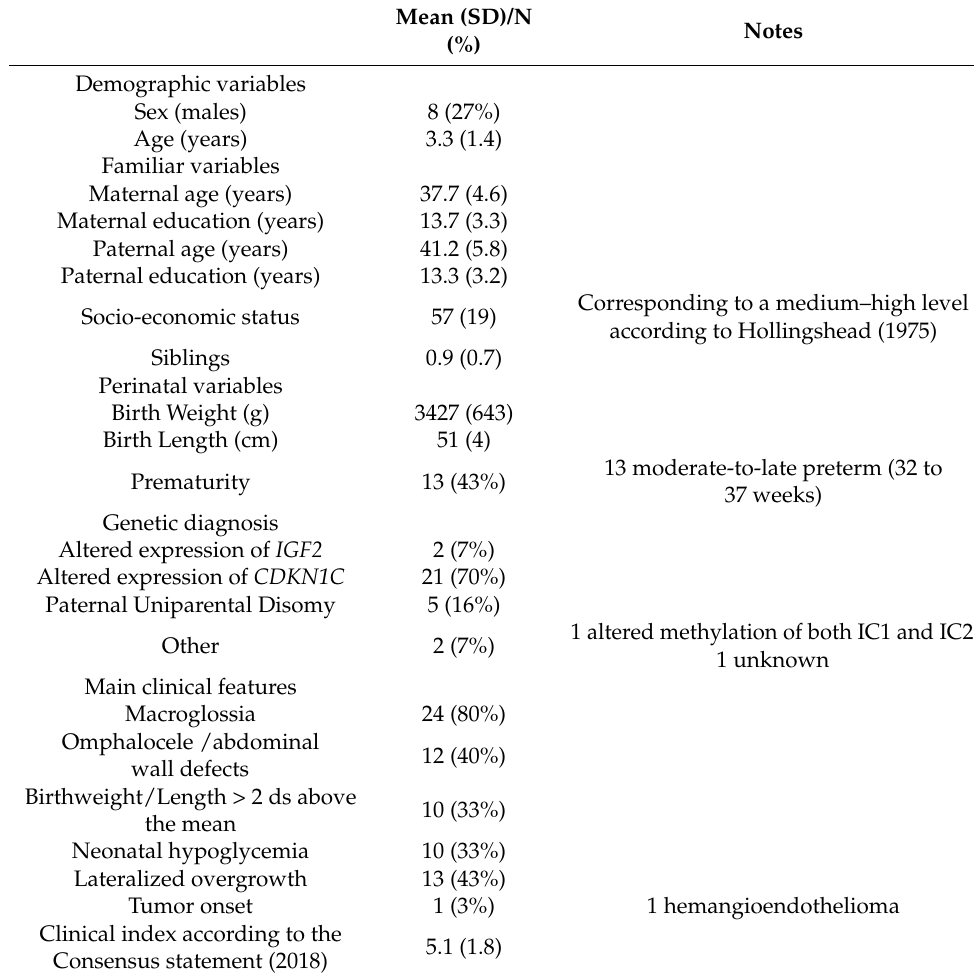
Table 1. Socio-demographic and clinical variables of the